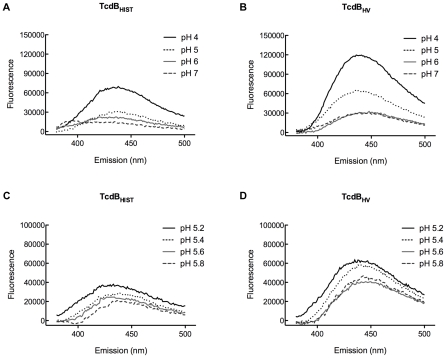
TNS analysis of pH-induced hydrophobic transitions in TcdBHIST and TcdBHV.TcdBHIST or TcdBHV was incubated with TNS for 20 min at 37°C. Samples were analyzed for changes in TNS fluorescence, and the emission profile of each pH is shown and labeled. Panels (A) and (B) represent pH 4.0 to pH 7.0 and panels (C) and (D) show TNS fluorescence of TcdB between pH 5.0 and 6.0. Each spectrum represents the experimental sample with background (TNS and buffer alone) subtracted.